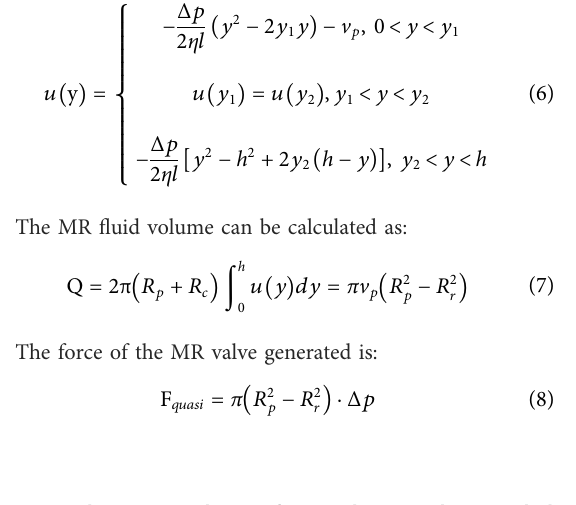
FIGURE 4 The fl ow pro fi le modeling for